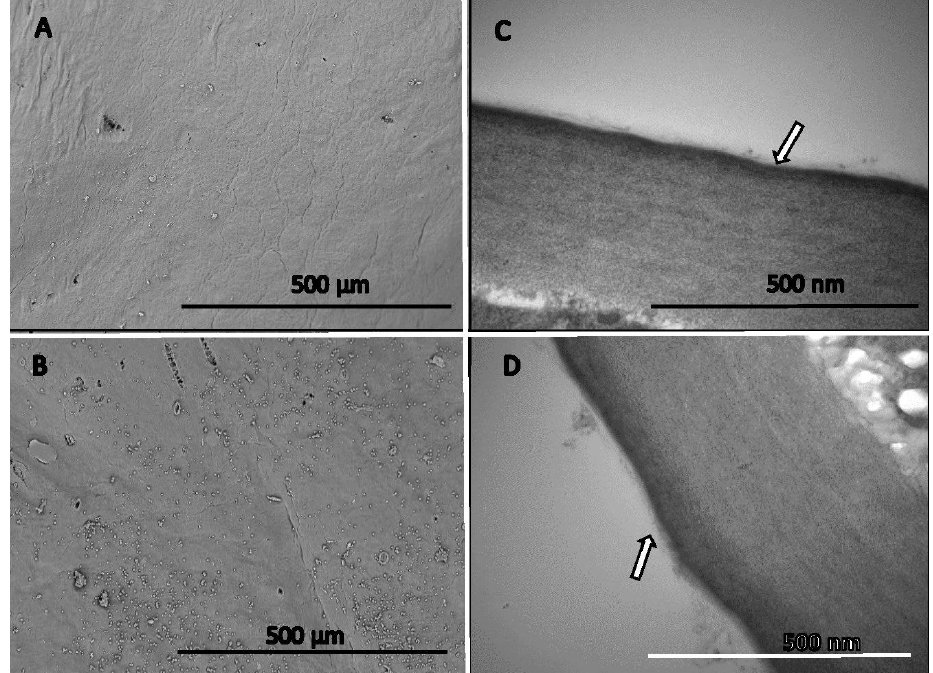
Figure 3. Scanning electron micrographs of orange fruit surfaces analyzed 30 ( A ) and 44 DAFB ( B ). Transmission electron micrographs of orange fruit epidermal cell wall and cuticle of fruits sampled 30 ( C ) and 44 DAFB ( D ). Arrows indicate the cuticle, and dark material underneath the cuticle corresponds to